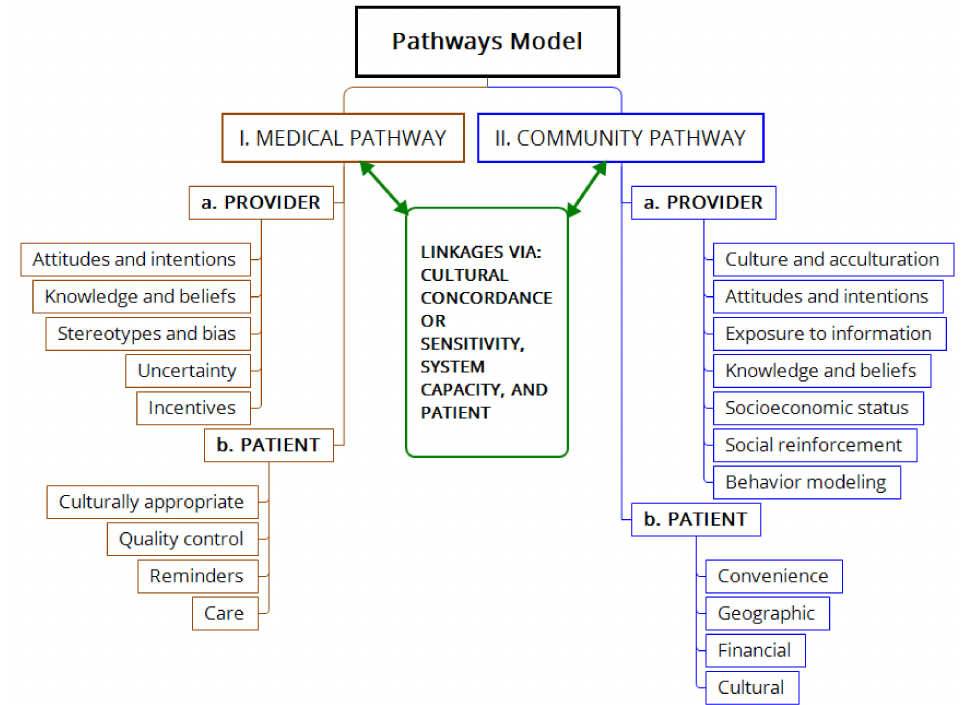
Figure 1. Conceptual diagram of the pathways model of health delivery which combines a medical pathway (left vertical) and a community pathway (right vertical), each of which involve both provider and patient characteristics. Cultural and social determinants strongly influence interactions between providers and patients in both